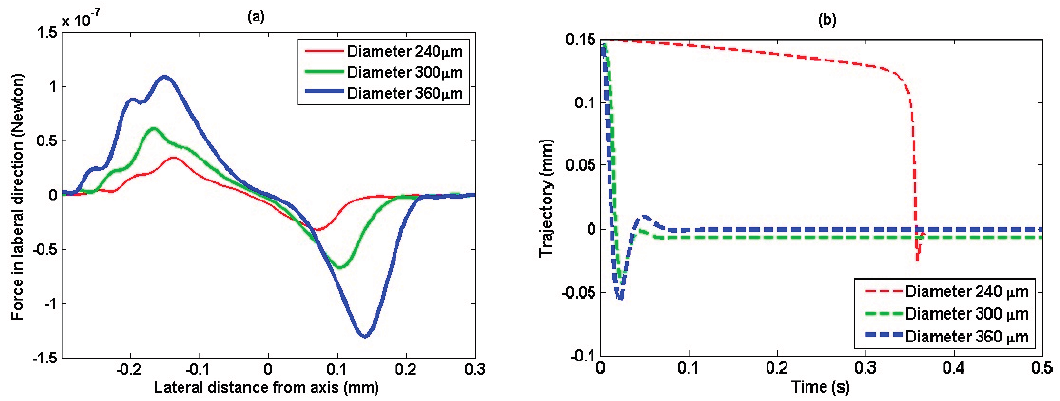
Figure 8. The radiation force and displacement trajectory across axial direction. ( a ) Lateral radiation force as they travelled across axial direction; ( b ) Displacement trajectory of the particles with various diameters across axial